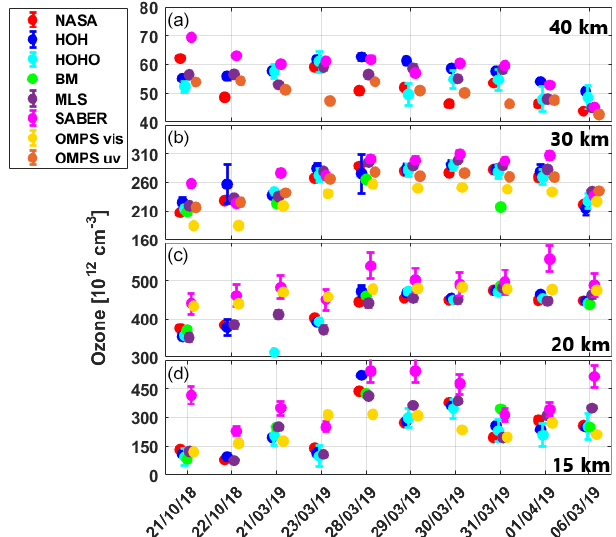
Figure 5. Time series of ozone measurements smoothed using a 2km boxcar average. Panel (a) contains ozone densities at 40km, panel (b) at 30km, panel (c) at 20km, and panel (d) at